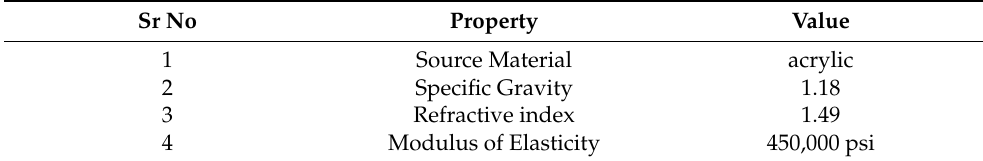
Table 5. Properties of